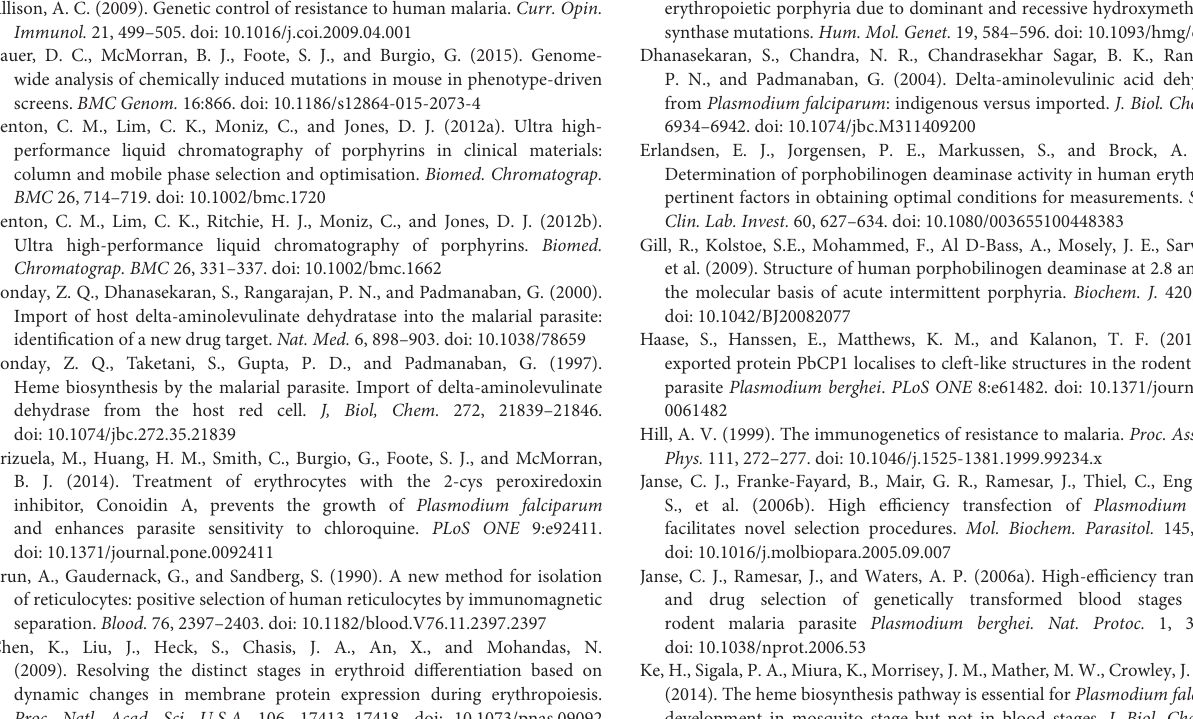
Figure S3 | Generation of Pbgd P. berghei knockout. (A) For targeted gene deletion of the PbANKA_060800, fragments of the 5 ′ UTR and 3 ′ UTR, which would serve as targeting regions to drive integration into the endogenous locus, were PCR-amplified from P. berghei ANKA genomic DNA and cloned into the p35/EF5’.Fluc.CAM3 ′ vector. Position of oligonucleotides used for PCR analysis are shown. (B) Representation of a gel electrophoresis on the genomic integration of the targeting construct using specific primers spanning the locus. SM, hDHFR selectable marker; I, integrant fragment size; E, non- integrant fragment size. Figure S4 | P. falciparum growth-inhibition assay flow cytometry gating strategy. Upper panels: Erythrocytes (RBC) selected according to side scatter area (SSC-A) and forward scatter area (FSC-A). Lower panels: P. falciparum -infected erythrocytes identified as Hoechst 33342 positive RBC. Examples are from uninfected RBC and samples collected 24 and 72h after parasite inoculation.